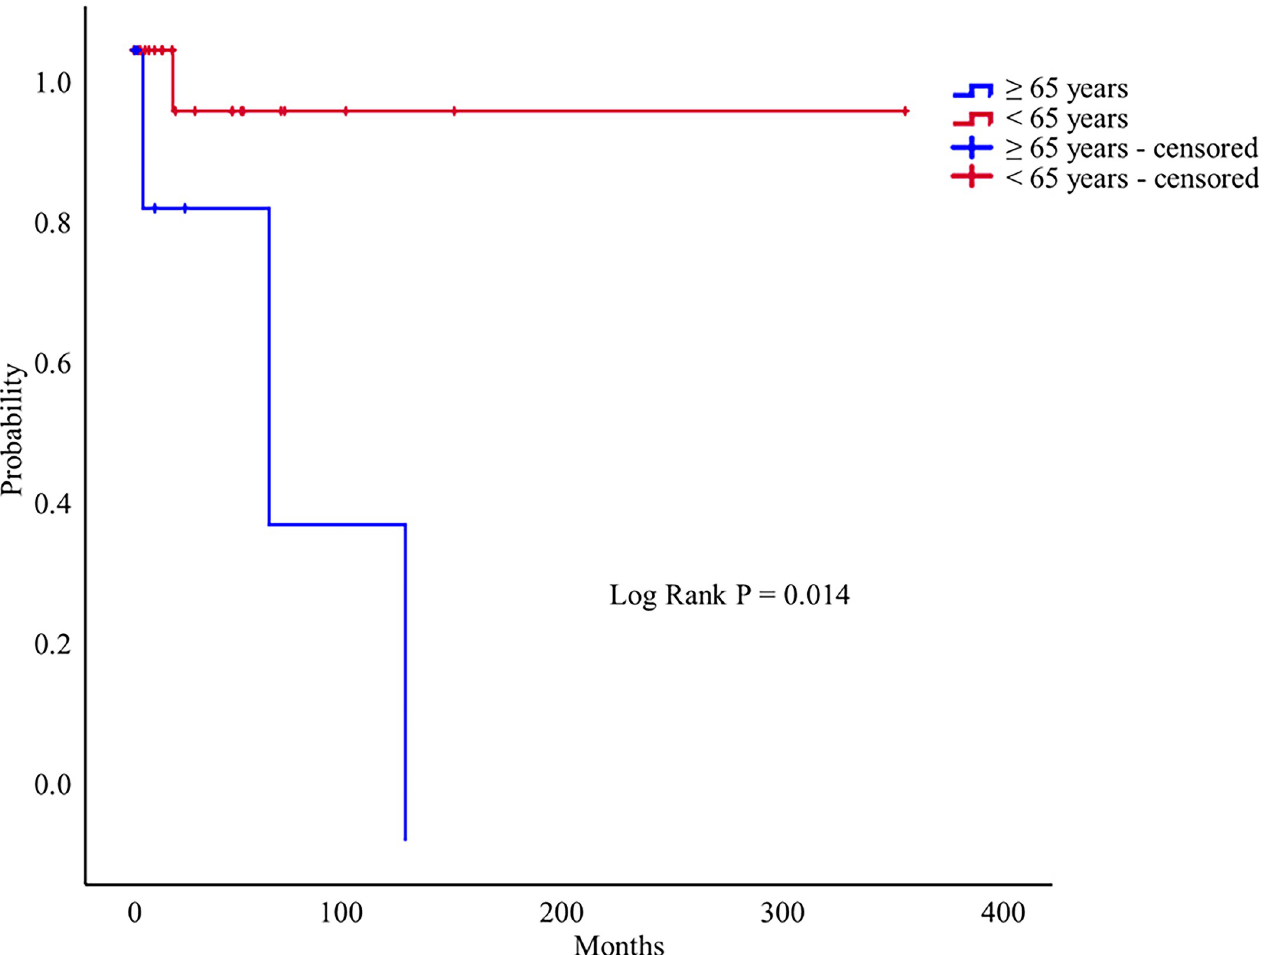
Fig 3. Kaplan–Meier curve illustrating the time without the development of new cerebral complications in untreated PAVM patients (n = 33).